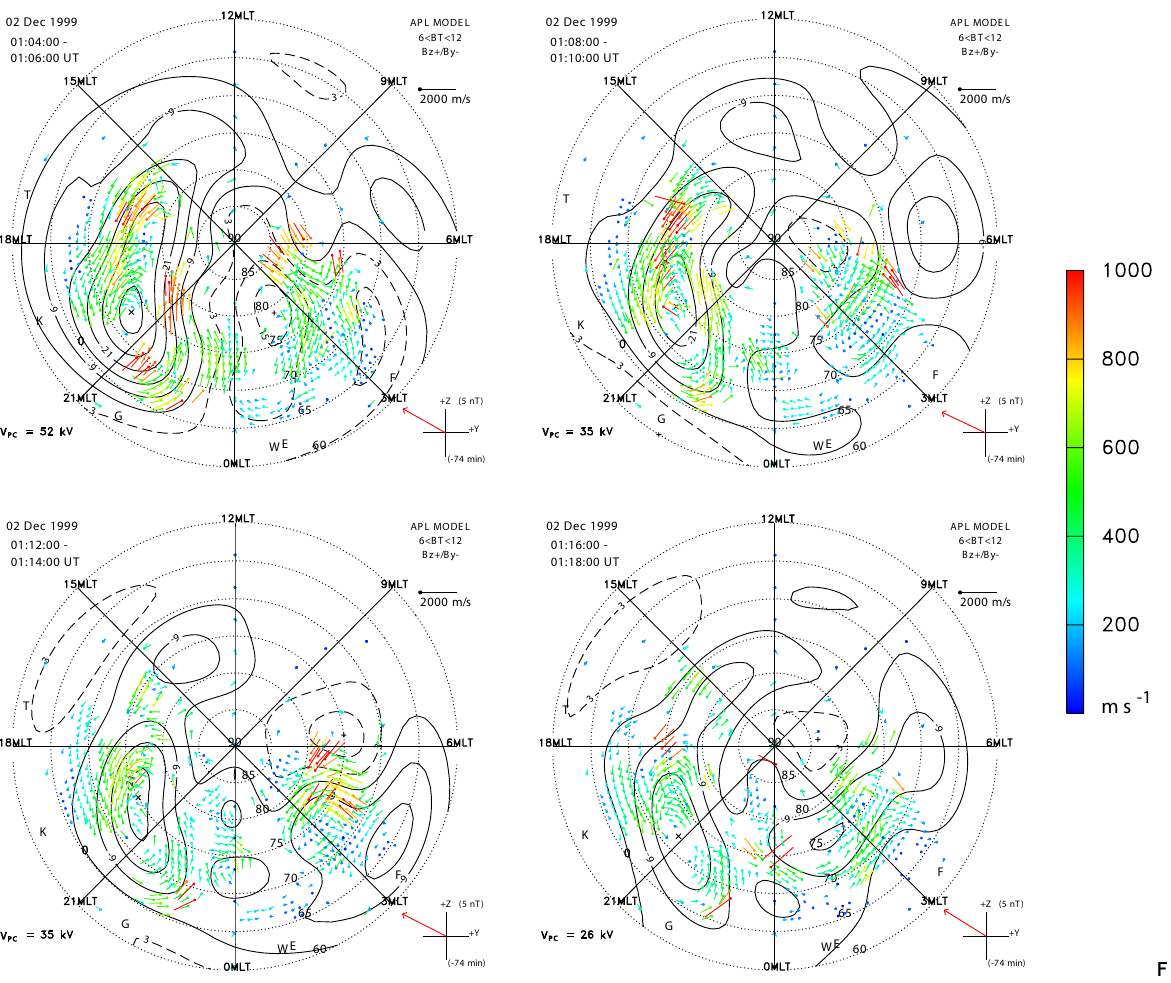
Fig. 6. Streamlines and vectors of the ionospheric flow derived from the six-radar SuperDARN velocity measurements are shown on a geomagnetic grid, obtained from the Map-Potential algorithm (see Sect. 2.1). The intervals displayed are (a) 00:32–00:46UT, (b) 00:48– 01:02UT and (c) 01:04–01:18UT on 2 December 1999. on 2 December 1999. Four maps are shown in each panel (a–c), corresponding to every other 2-min radar experiment cycle. Indicated at the bottom of each map is the total transpolar voltage V PC (left-hand corner), and the direction and magnitude (in the Y − Z plane) of the IMF (right-hand corner). In the top right-hand corner we indicate the flow model employed to stabilize the potential solution in regions where no data are available, obtained from the statistical study of Ruohoniemi and Greenwald